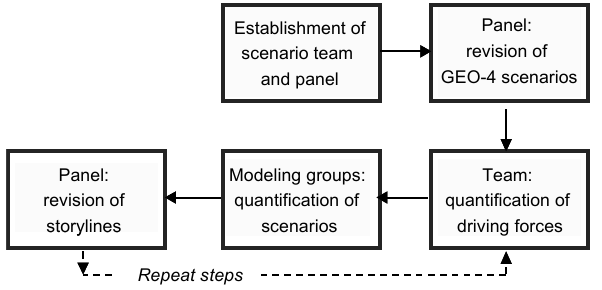
Figure 1. The interaction between the qualitative and quantitative scenario development in the SAS (story and simulation) approach (simplified from Alcamo,